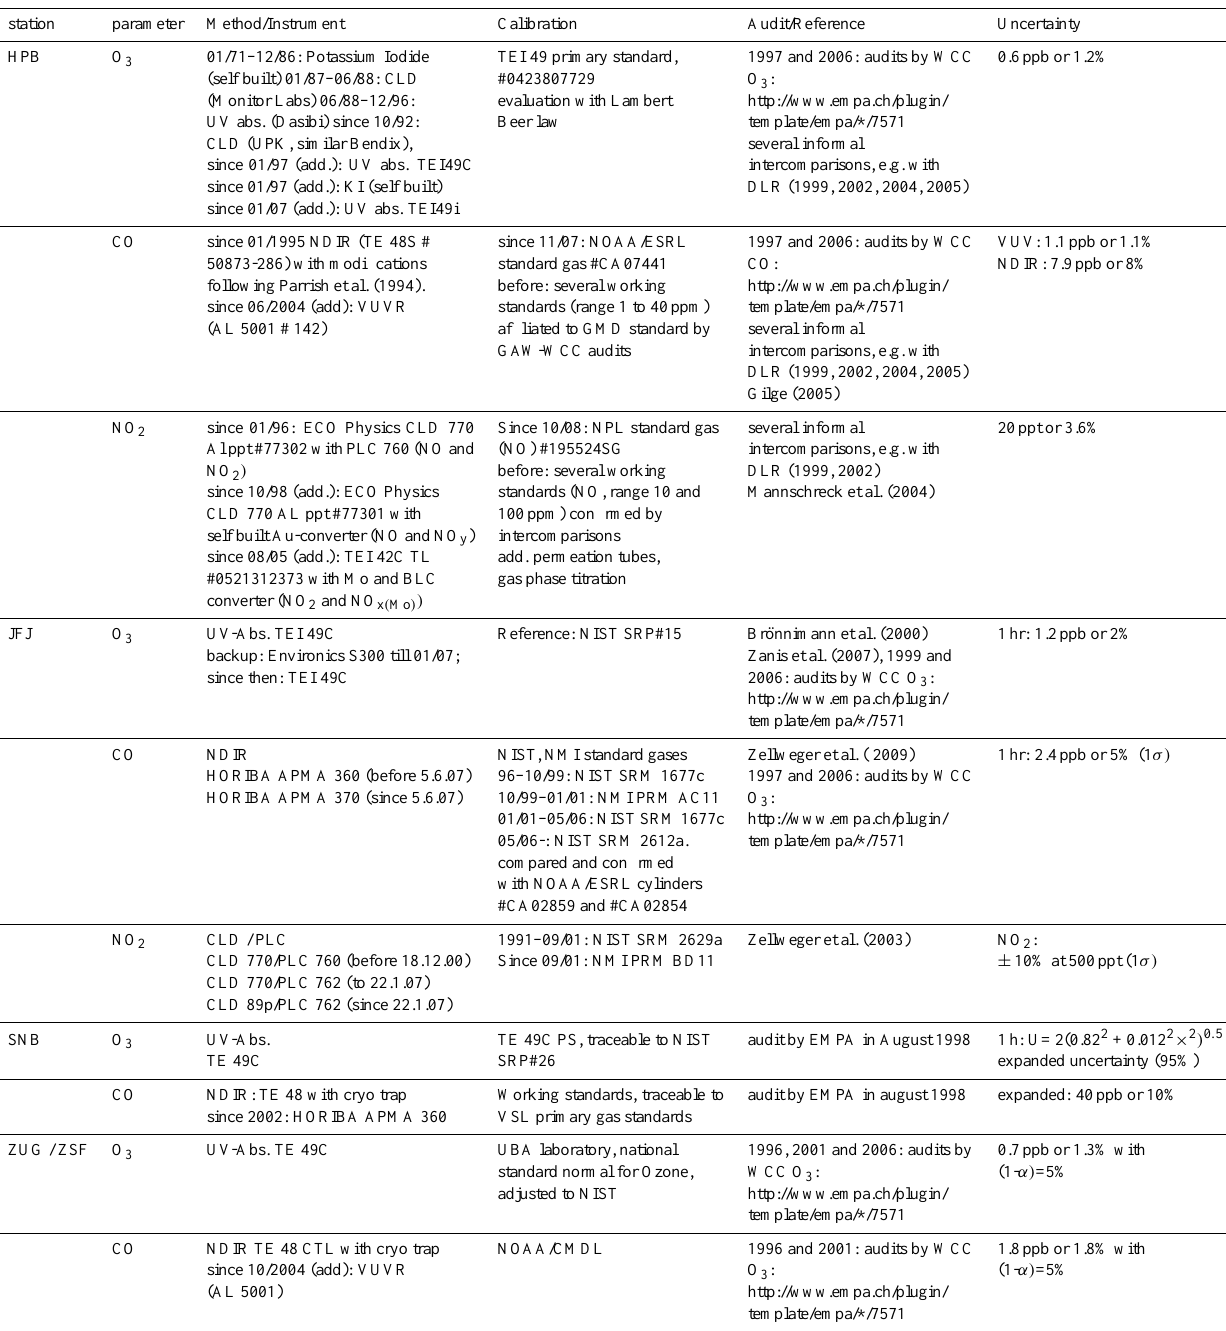
Table 2. Measurement techniques, calibration, and uncertainty of